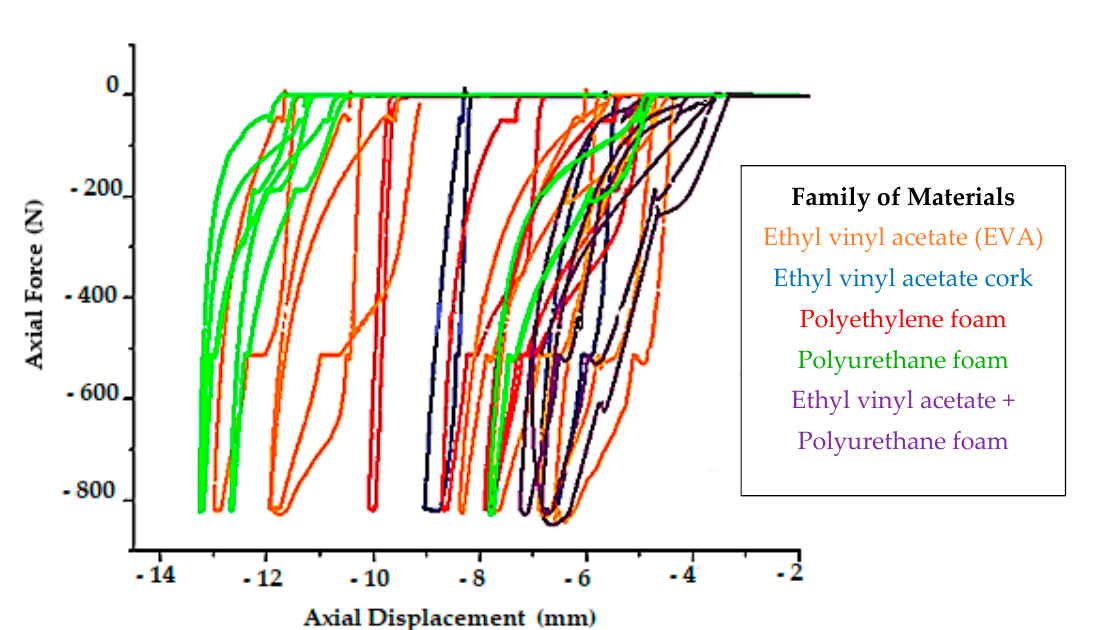
Figure 4. Representation of the materials subject to study, where the energy dissipation areas are apparent (Static test).